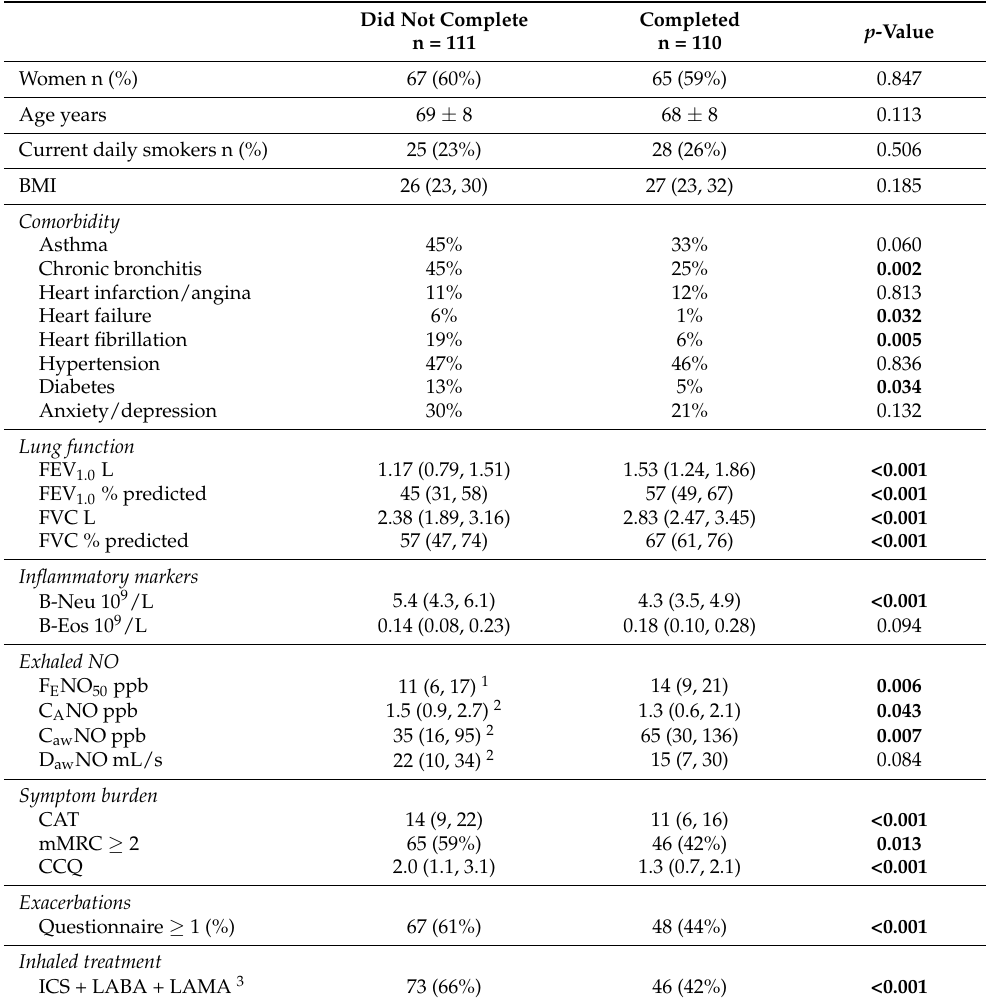
Table 1. Characteristics of the study subjects at inclusion who completed or did not complete the